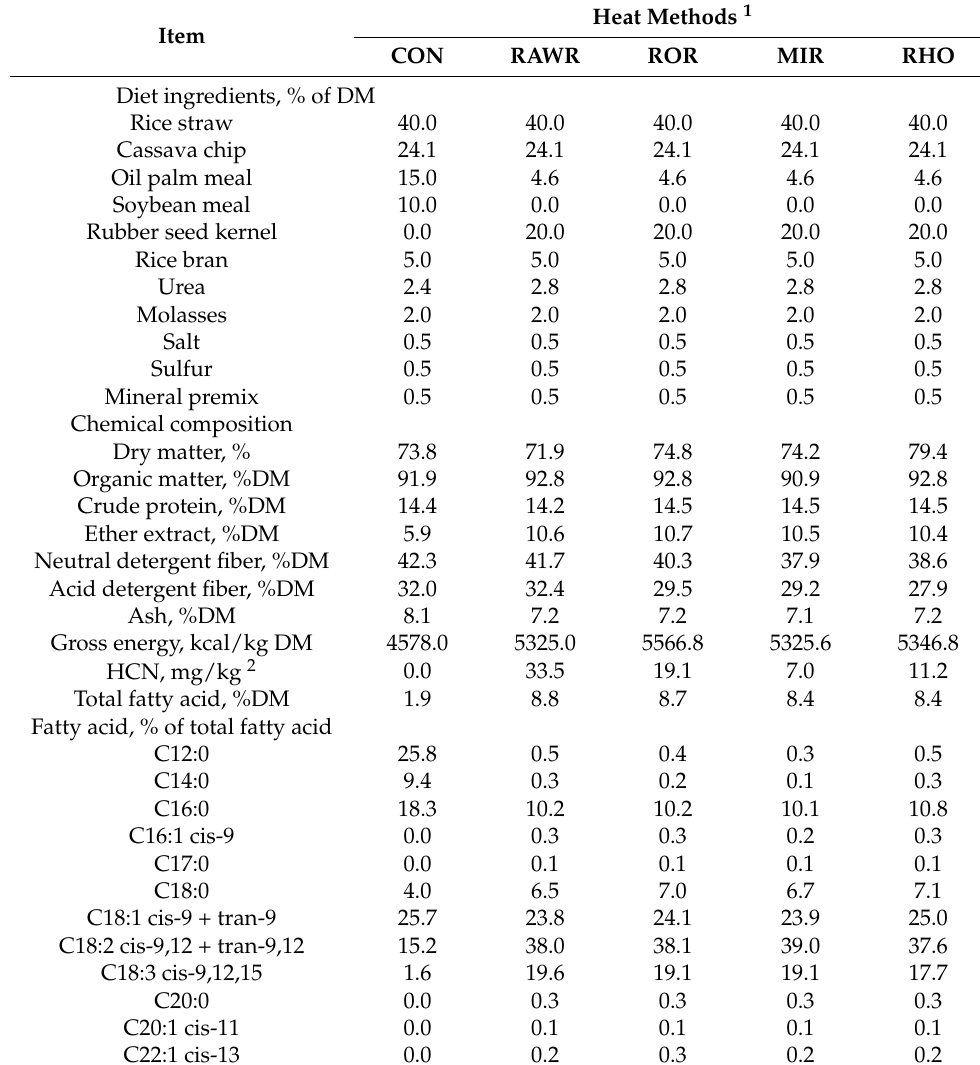
Table 1. Ingredients and chemical composition of the diet used in the